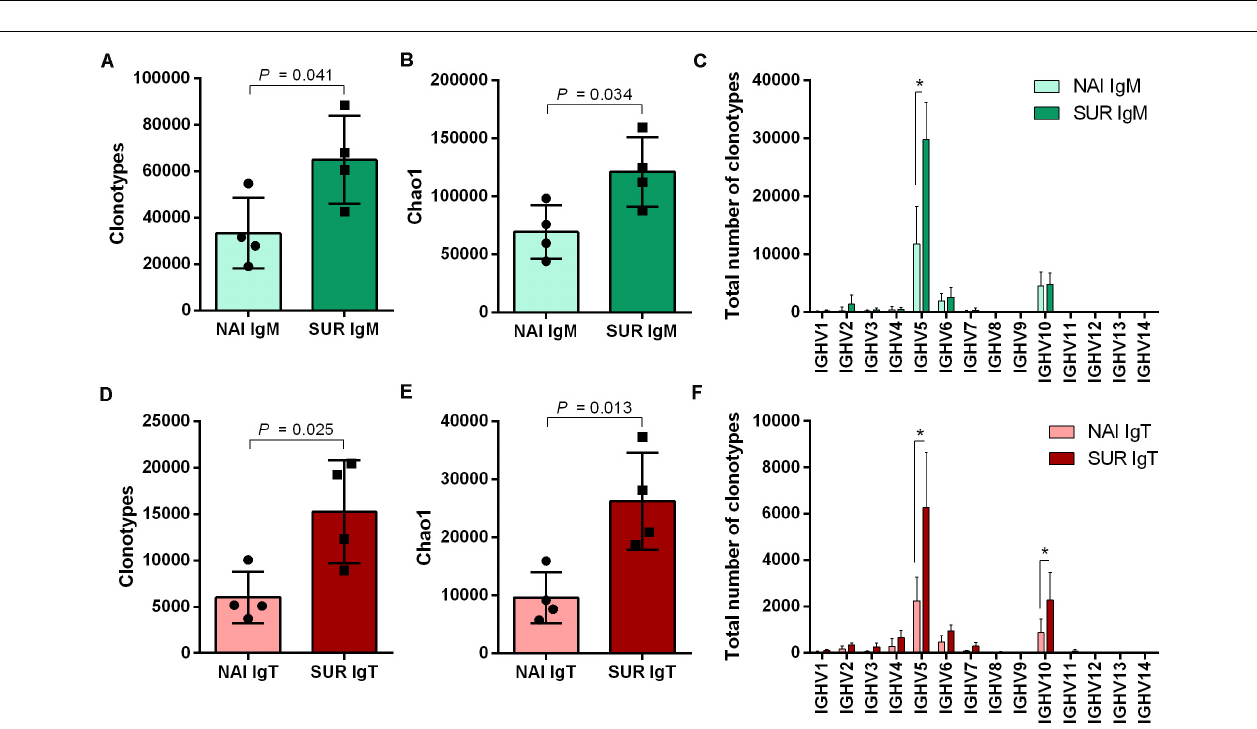
FIGURE 4 | Circulating antibodies. Total IgM (A) , IgT (B) , and parasite-specific IgM (C) in fish injected with PBS, or with serum without (NAI) or with (SUR) parasite-specific antibodies. The negative control (CTRL-) were fish not challenged with the parasite. Different letters indicate significant differences among groups ( P < 0.05).